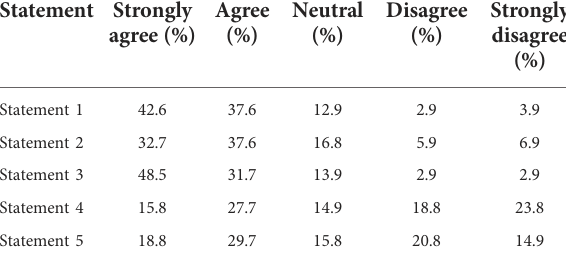
TABLE 4 Summary of responses from self-administered questionnaire